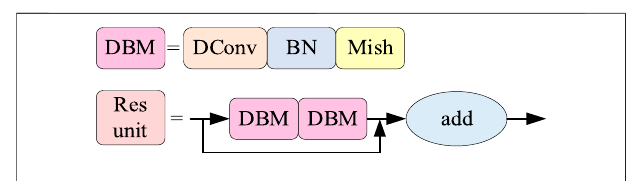
FIGURE 6 | Residual block network structure with deformable